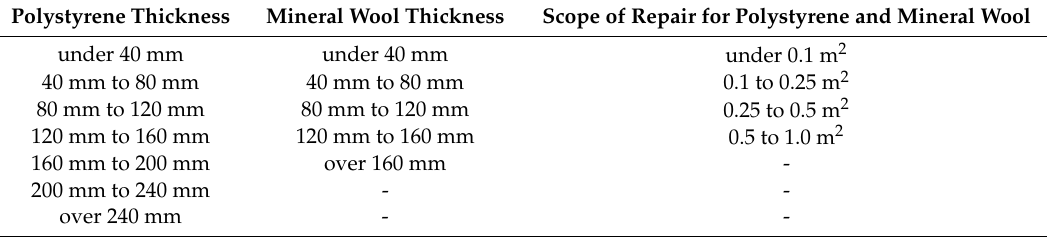
Table 5. Division of ETICS repairs according to price database [46].